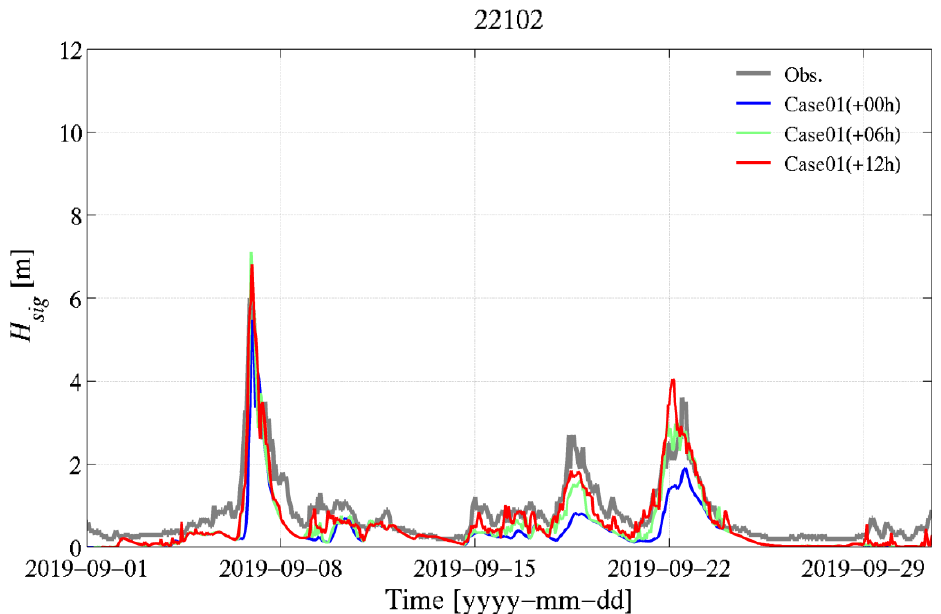
Figure 8. Comparison of the observed and simulated significant wave heights for each forecast lead time at the observation point of 22102.